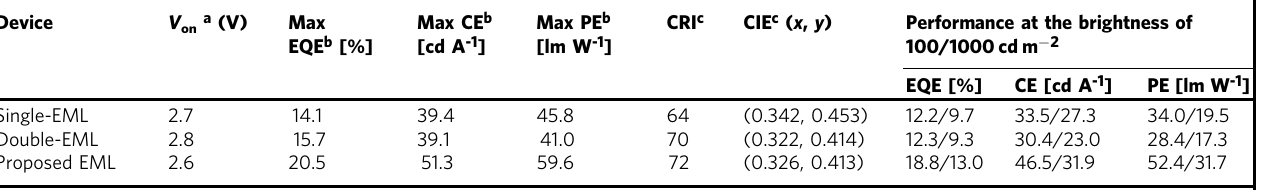
Table 1 Summary of device performances Device